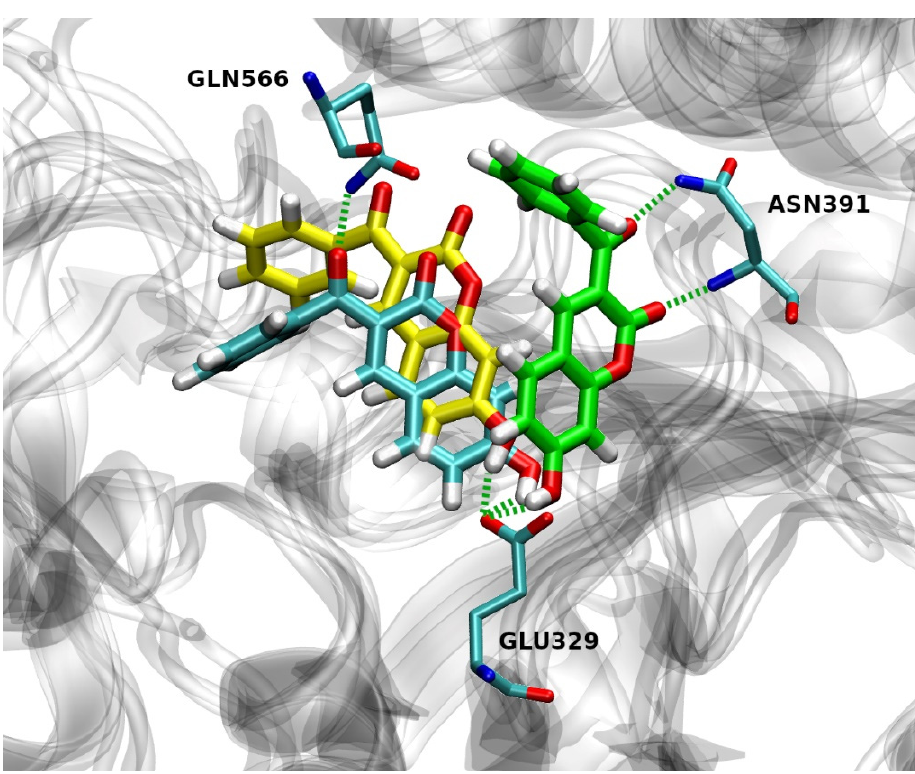
Figure 7. Overlay of the hDPP III with compound 12 in its preferable binding mode after 300 ns of MD simulation for run 1 (cyan), run 2 (green) and run 3 (yellow). Hydrogen bonds are depicted as green dashed lines.